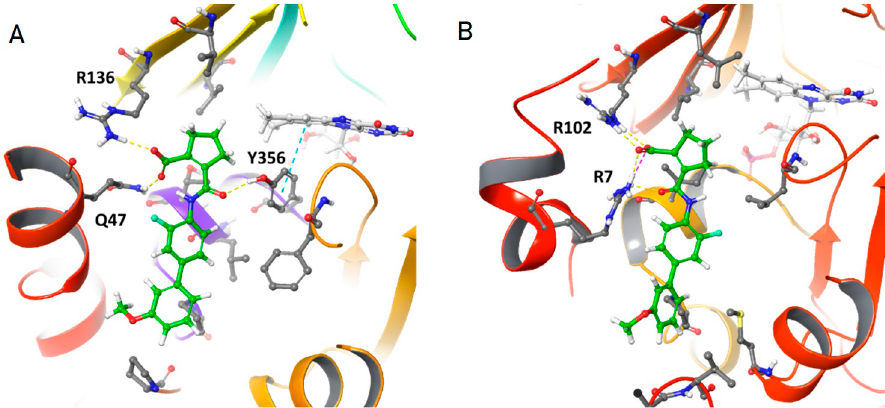
Figure 5. Model of VF-DHOD interaction. ( A ) VF (in green) docked to hDHOD showed an interaction between the VF carboxylic acid moiety and both R136 and Q47. A third interaction is observed between the amide group of VF and the hydroxyl group of Y356. ( B ) When VF is docked to EcDHOD we observed that the VF carboxylic acid moiety form interactions with R102 (equivalent to R136 in human) and R7 (in place of Q47 in human). The VF amide group does not form any interaction.